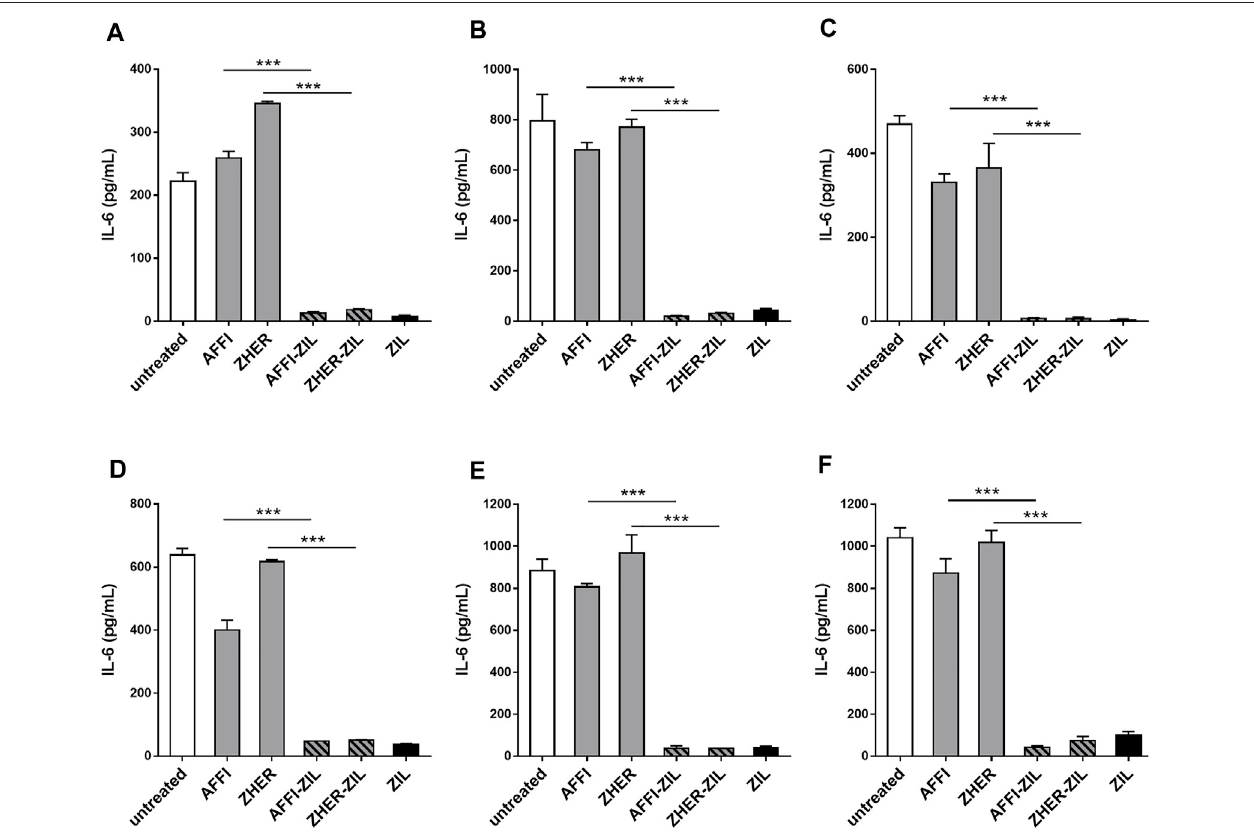
FIGURE 6 | L. lactis co-expressing IL-6 binder ZIL and the tumor antigen binder ZHER or AFFI removes IL-6 secreted by THP-1 cells and U-937 cells. ELISA- determined concentrations of IL-6 after incubation of engineered L. lactis (6 × 10 9 CFU/ml) with conditioned media of LPS-stimulated THP-1 (A) , differentiated THP-1 (B) , or differentiated U-937 (C) cells, and after co-culture of engineered L. lactis strains with LPS-stimulated THP-1 (D) , differentiated THP-1 (E) , or differentiated U-937 (F) cells. The cells were differentiated byincubation with phorbol 12-myristate 13-acetate for 48 h. L. lactis strains tested: L. lactis -AFFI-ZIL and L. lactis -ZHER-ZIL ( L. lactis co-expressing tumor antigen binders and ZIL); Negative controls: L. lactis -AFFI-IRFP and L. lactis -ZHER-IRFP ( L. lactis co-expressing tumor antigen binders and IRFP); Positive control: L. lactis - ZIL ( L. lactis expressing cytokine binder ZIL only). Data are means ± SD, with experiments performed in triplicate. ***, p < 0.001 (unpaired t-tests), between the relevant bacterial pairs ( L. lactis co-expressing cytokine binders and tumor antigen binders, and negative